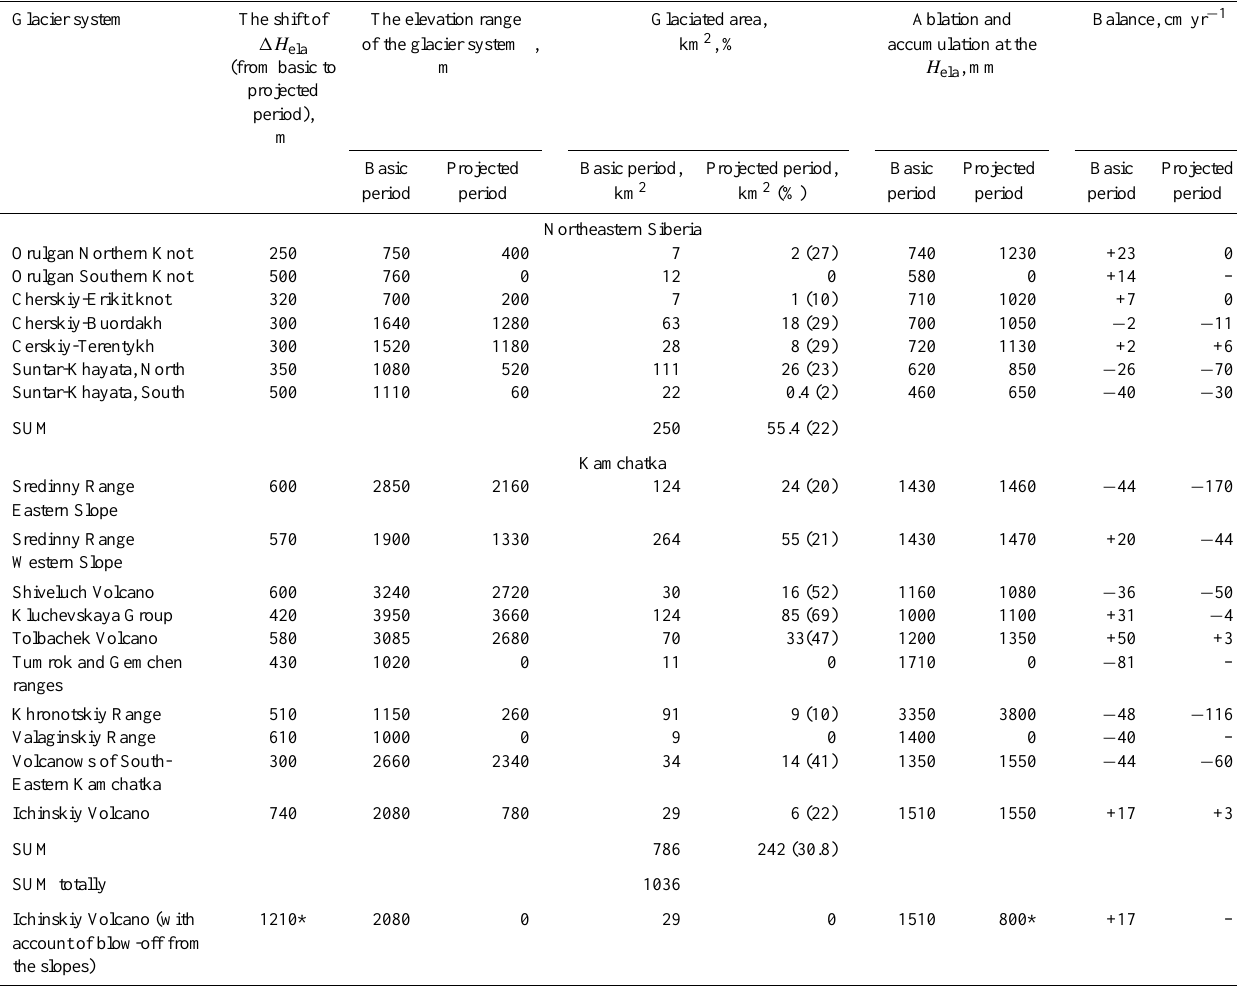
Table 1. Change of glacier systems characteristics in Northeastern Siberia and Kamchatka up to the mid 21st century (2040–2069). Glacier system The shift of The elevation range Glaciated area, Ablation and Balance, cmyr − 1 1H ela of the glacier system , km 2 , % accumulation at the (from basic to m H ela , mm projected period), m Basic Projected Basic period, Projected period, Basic Projected Basic Projected period period period Northeastern Siberia Orulgan Northern Knot